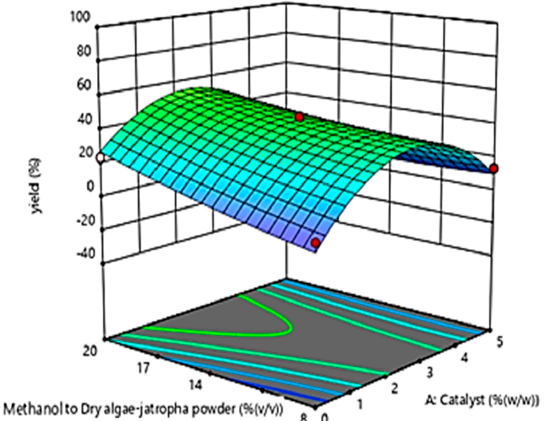
Figure 5. Biodiesel yield (%) vs. catalyst amount (%) and methanol/oil ratio (%).